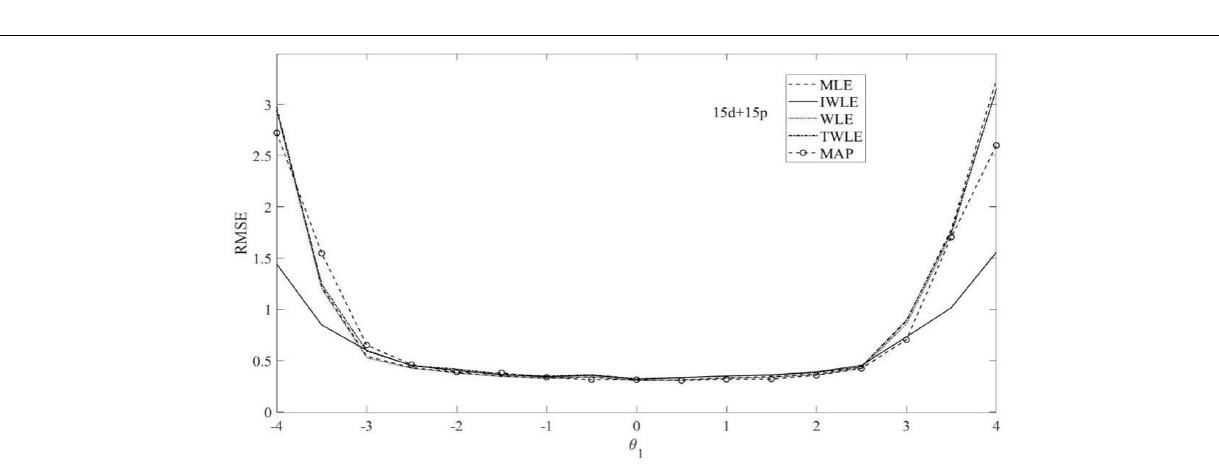
FIGURE 3 | RMSE of the five θ 1 estimation methods MLE, MAP, IWLE, WLE, and TWLE for 20d+10p.